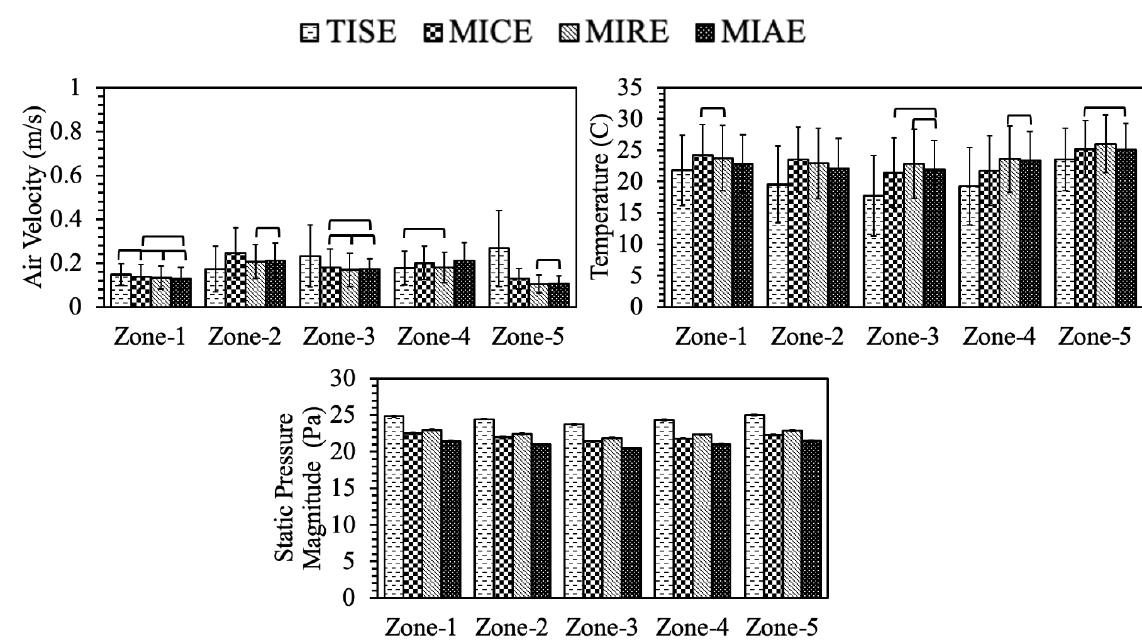
Figure 12. Environmental parameters of hen-occupied zones at Plane N in four models. Crossbars indicate no statistically significant differences at 95% family-wise confidence level. Error bars stand for the standard deviation.